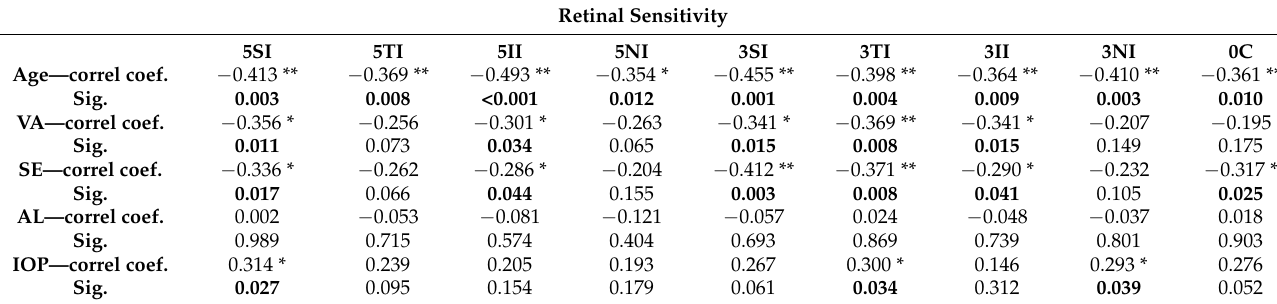
Table 3. Spearman’s correlation between the retinal sensitivity measured by the MAIA microperimeter in the 9 ETDRS areas and the different parameters of visual function and age for the DM1 group. Statistically significant difference between groups ( p < 0.05) are in bold. Correlation coefficient with p < 0.05 have one asterisk and with p < 0.01 have two asterisks. Nine ETDRS areas: SE, superior external; TE, temporal external; IE, inferior external; NE, nasal external; SI, superior internal; TI, temporal internal; II, inferior internal; NI, nasal internal; C-global, central; VA, visual acuity; SE, spherical equivalent; AL, axial length; and IOP, intraocular